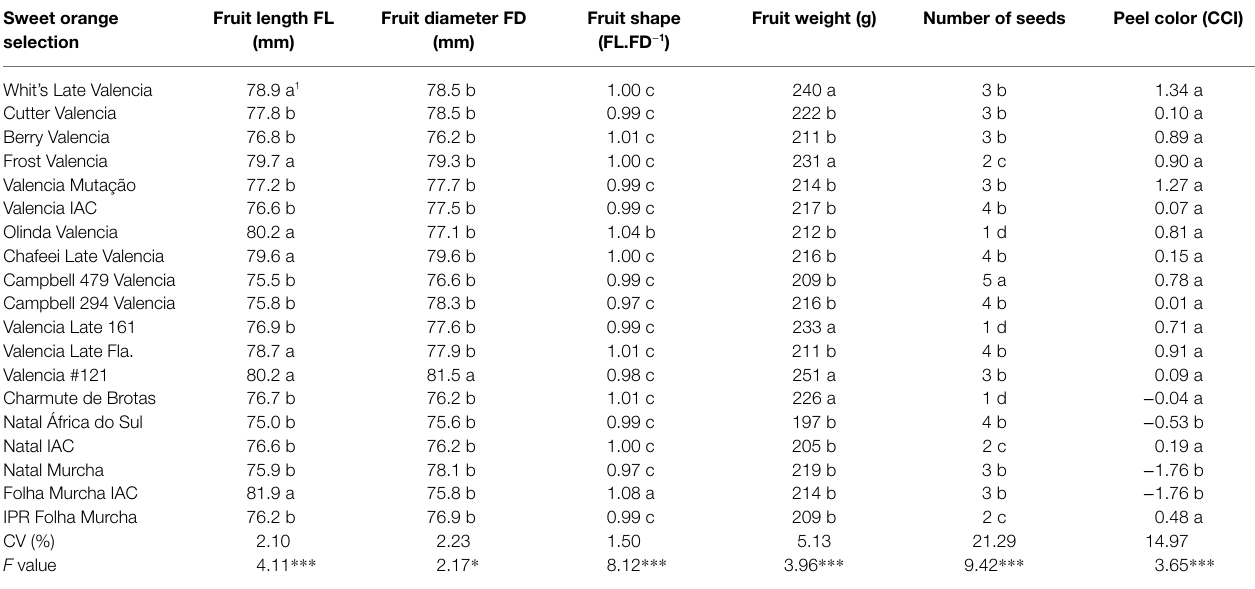
TABLE 4 | Three-season average fruit quality of 19 late-season sweet oranges produced in Guairaçá, state of Paraná, Brazil, from 2019 to 2021. Sweet orange Fruit length FL selection (mm)